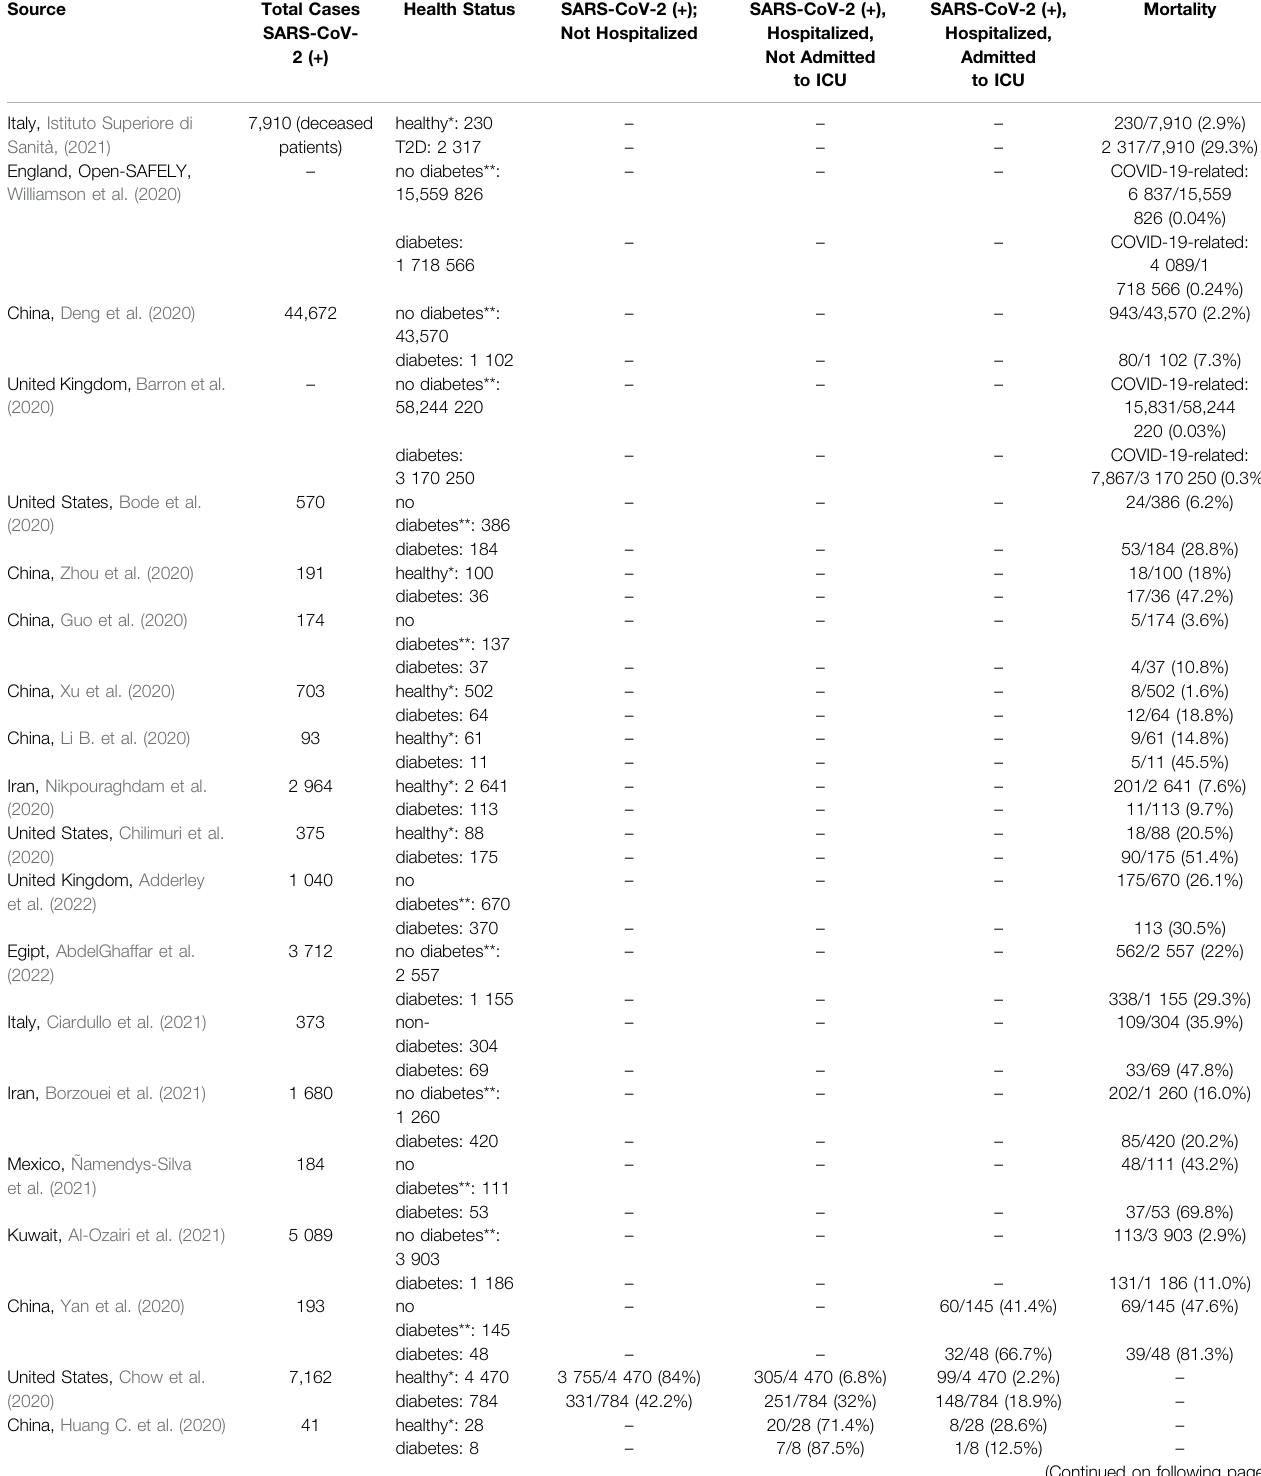
TABLE 1 | COVID-19 outcome in people with diabetes and control population. Results for diabetic patients were compared to either people without any diagnosed comorbidities ( “ healthy ” ) or people without diabetes, but with unknown status of other comorbidities ( “ no diabetes ” ). Articles containing 1) speci fi ed number of patients examined in the particular study, and 2) a control group (either healthy patients with no comorbidities or non-diabetic patients that could have other comorbidities) allowing a direct comparison with diabetic patients, were included in the table. ICU – intensive care unit; T2D – type 2 diabetes; — no data; * the patients did not show any of the examined comorbidities; ** patients did not have diabetes but might have other